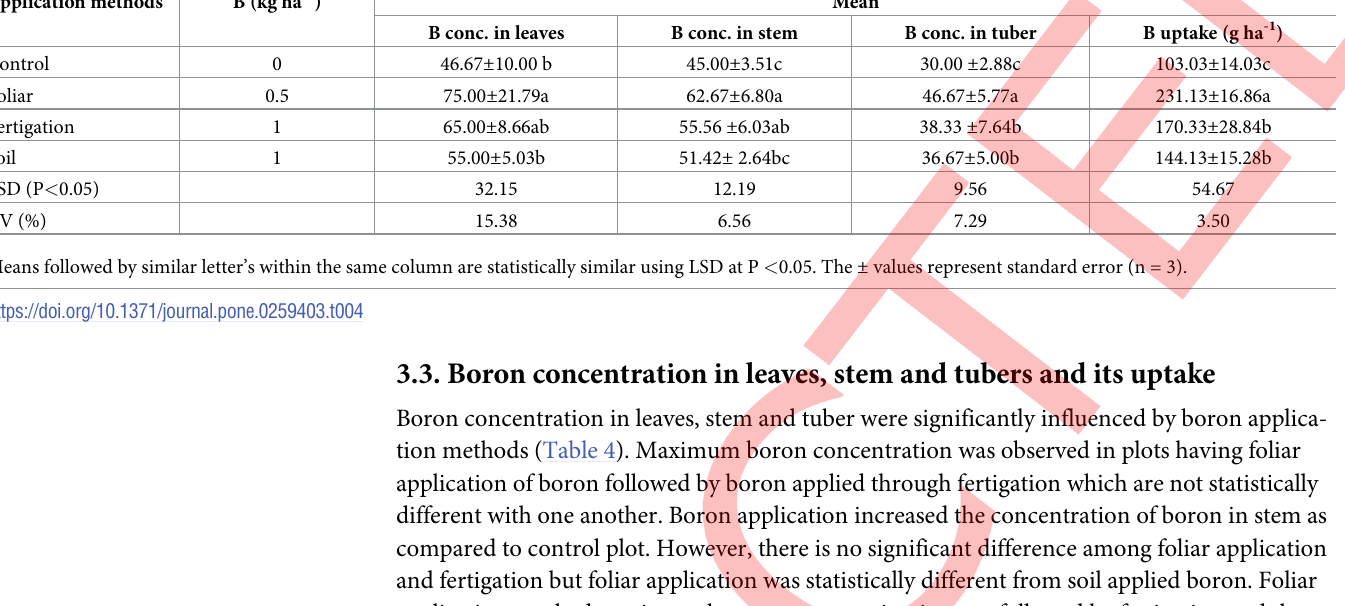
Table 4. Effects boron application methods on boron concentration in leaves, stem, tuber and its uptake by potato crop. Application